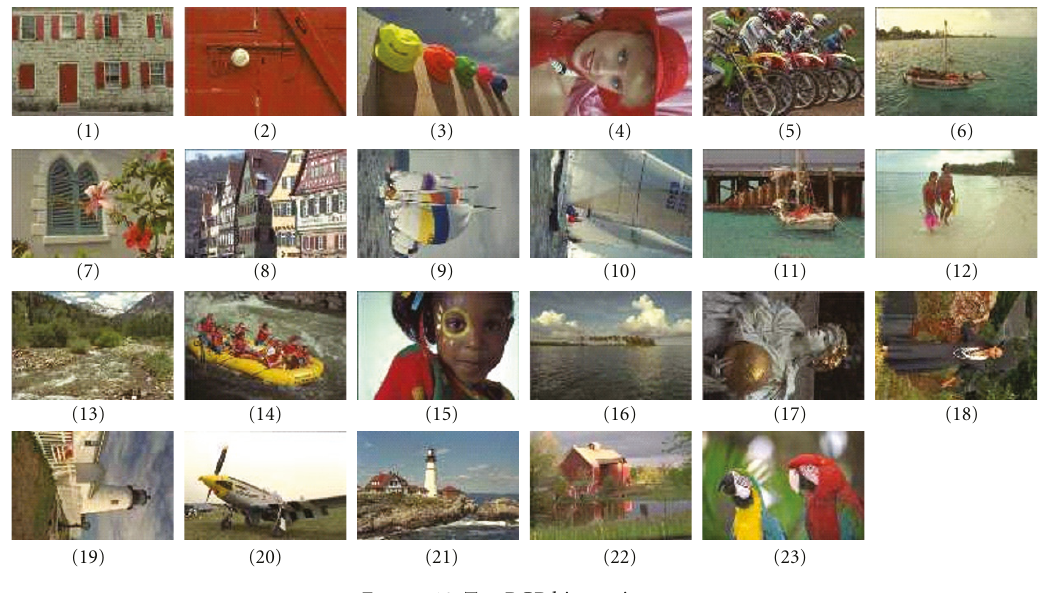
Figure 18: Test RGB bitmap images.